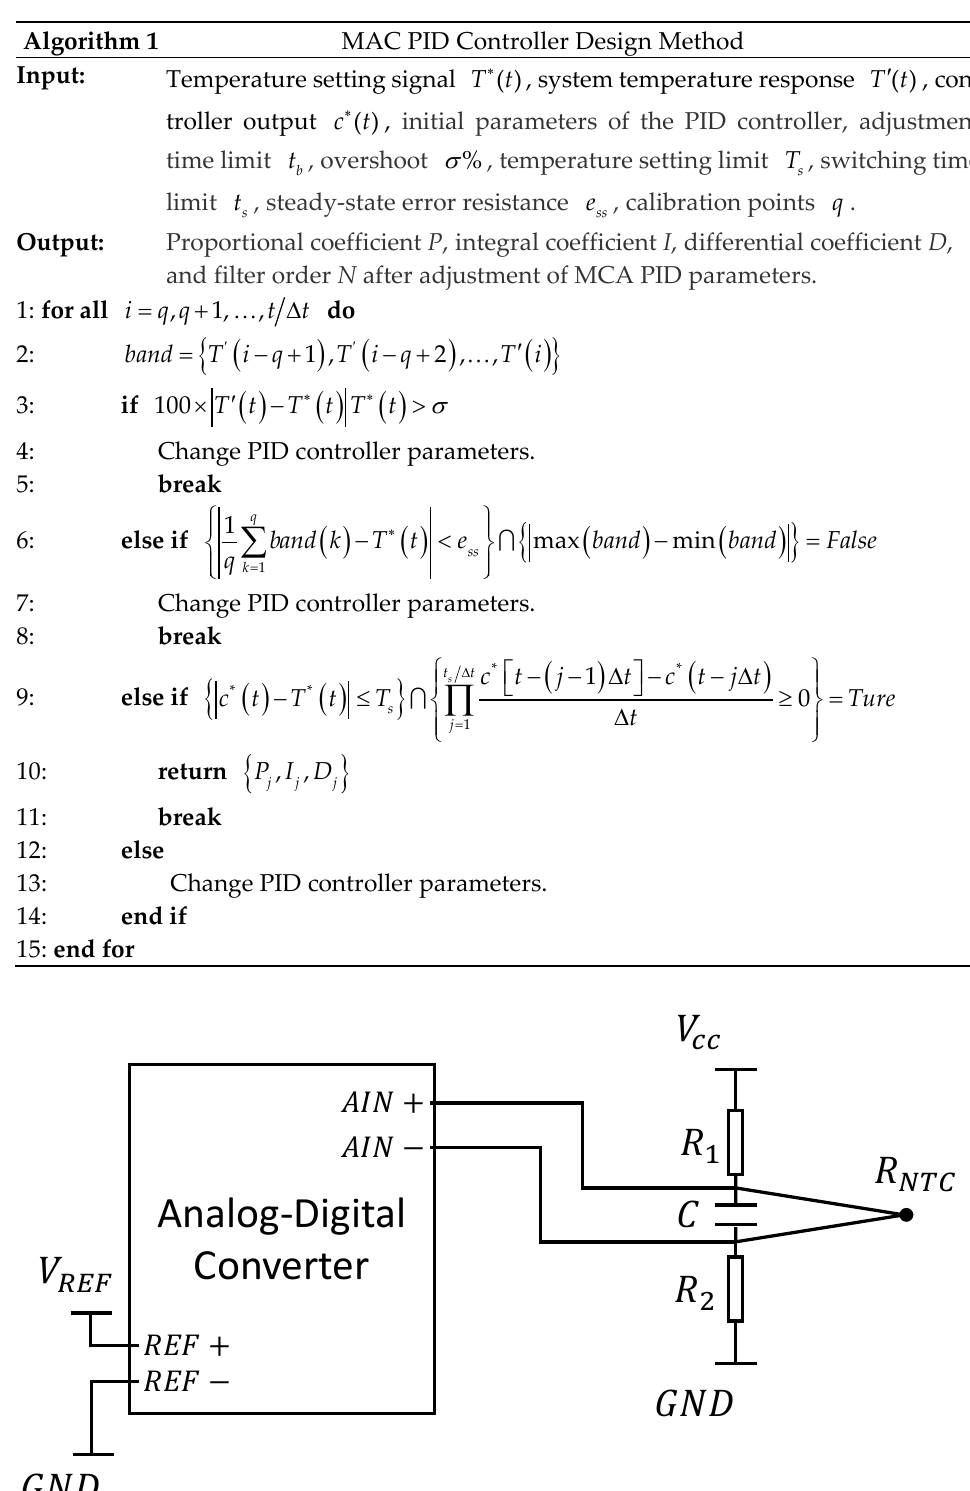
Table 1. This is a table. Tables should be placed in the main text near to the first time they are cited.